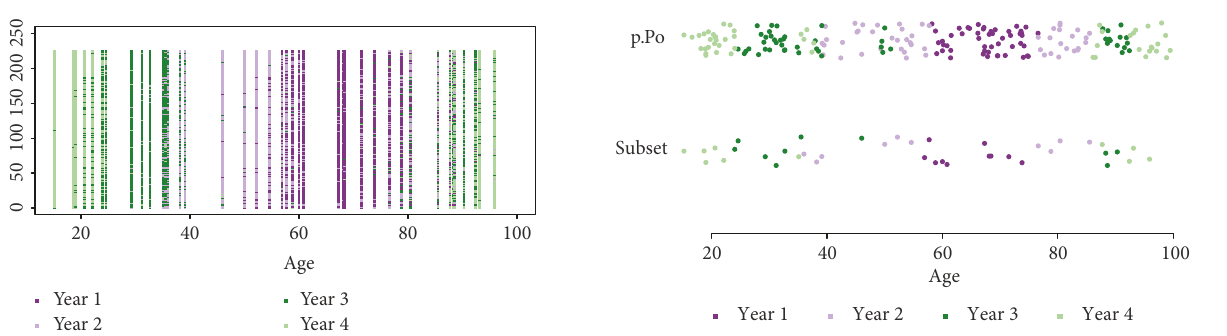
Figure 6: Consumption pattern, for a subset of 40 units, for the 225 strategies identified on the Phase I Pareto front. The units are sorted based on their current ages with the coloring of each unit representing the time period in which the solution assigns the unit to be used (dark purple = Year 1; light purple = Year 2; dark green = Year 3; light green = Year 4).